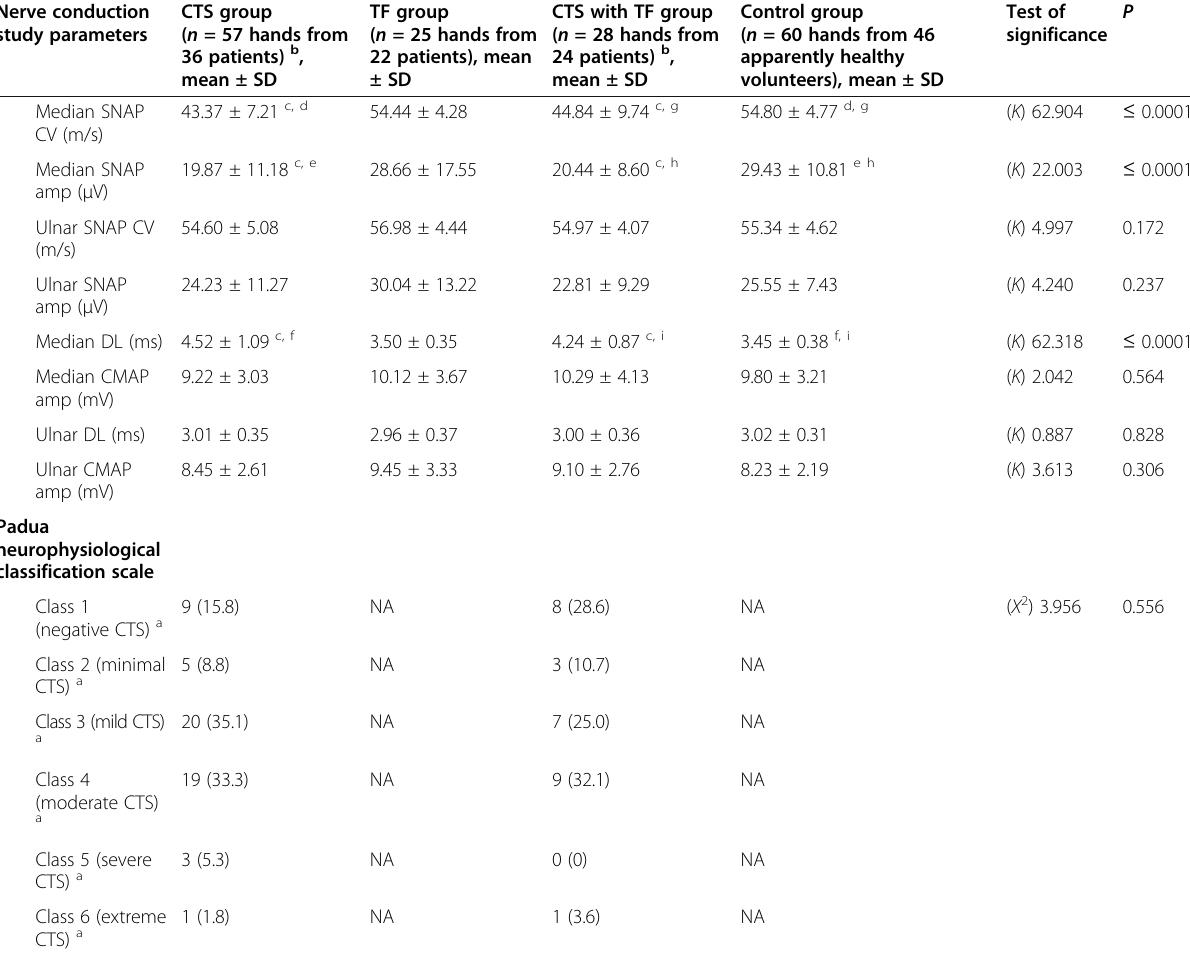
Table 3 Comparison of different nerve conduction study parameters between the three patients ’ groups and the control group Nerve conduction study